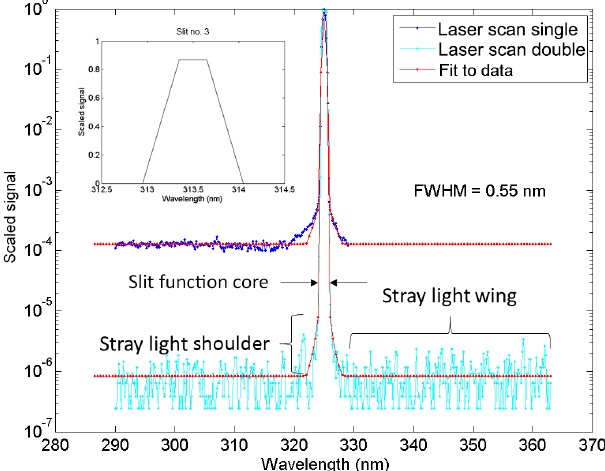
Figure 1. Slit functions measured with a He-Cd laser for single no. 009 and double no. 119 Brewers at Mauna Loa as well as fitted models; the ideal slit function is also shown inside the main